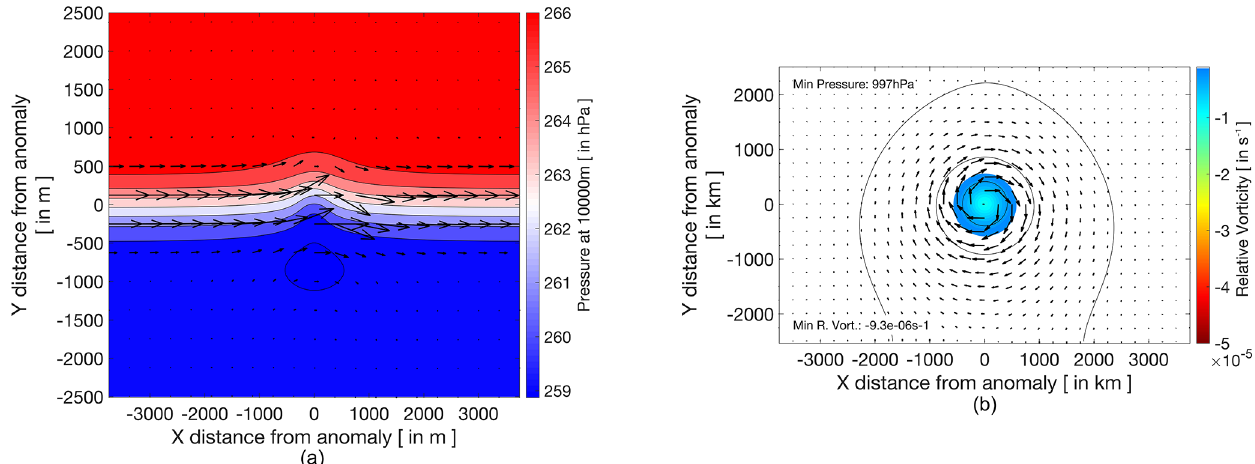
Figure 6. (a) Upper-level (10000ma.g.l., 2500m below the experimentally defined dynamical tropopause) pressure field (shaded), together with wind vectors plotted as black arrows. (b) Surface pressure isobars (black lines) and surface relative vorticity (shaded), together with surface wind vectors plotted as black